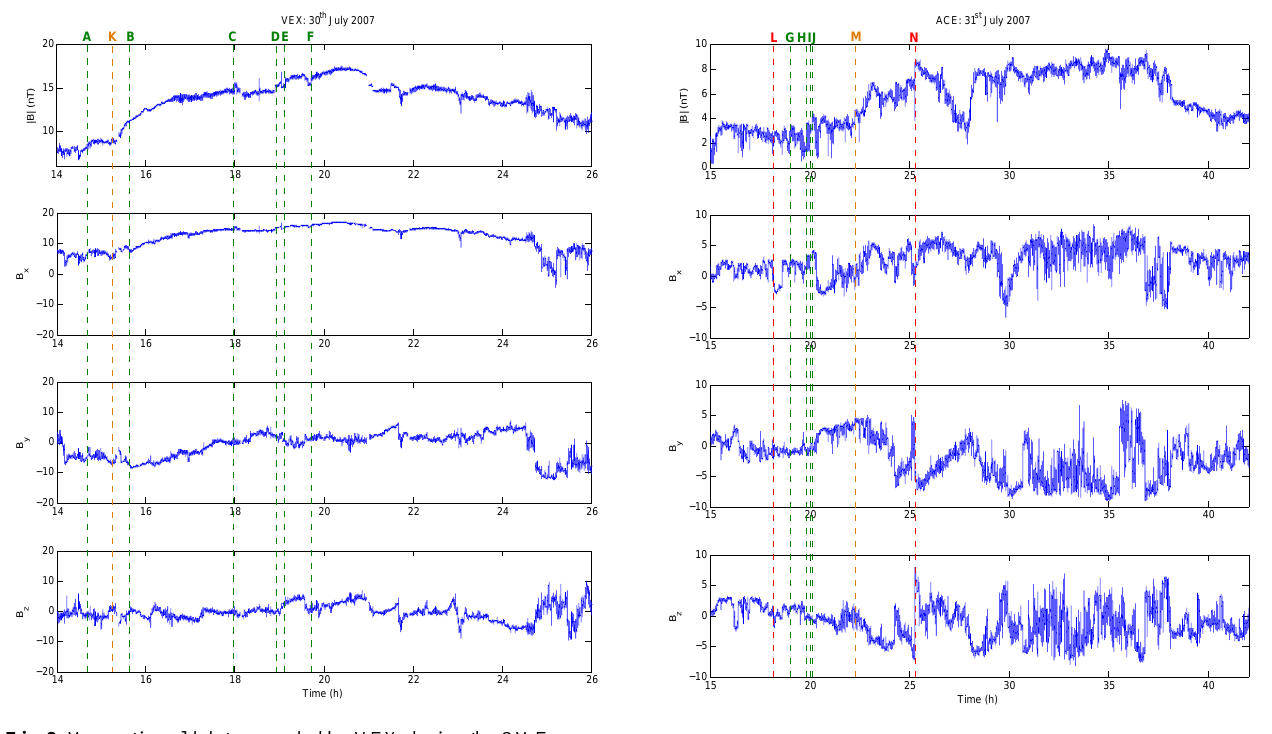
Fig. 4. Magnetic field data recorded by ACE during the CME cross- ing period on 31 July 2007. The vertical green dotted lines (G:J) mark the shock crossing times, the vertical orange dotted line (M) represent an example of a nonlinear structure that has not fully formed into a shock and the red dotted lines (L and N) represent some examples of nonlinear structures that did not fulfil the criteria for a shock